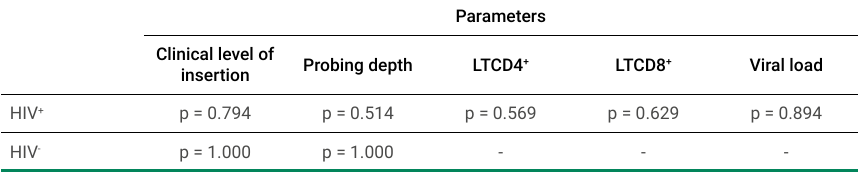
Table 2. Results of the Spearman correlation test between IL-10 and the clinical parameters of chronic periodontitis, serology and viral load in HIV-1 and non-HIV-1 carriers.